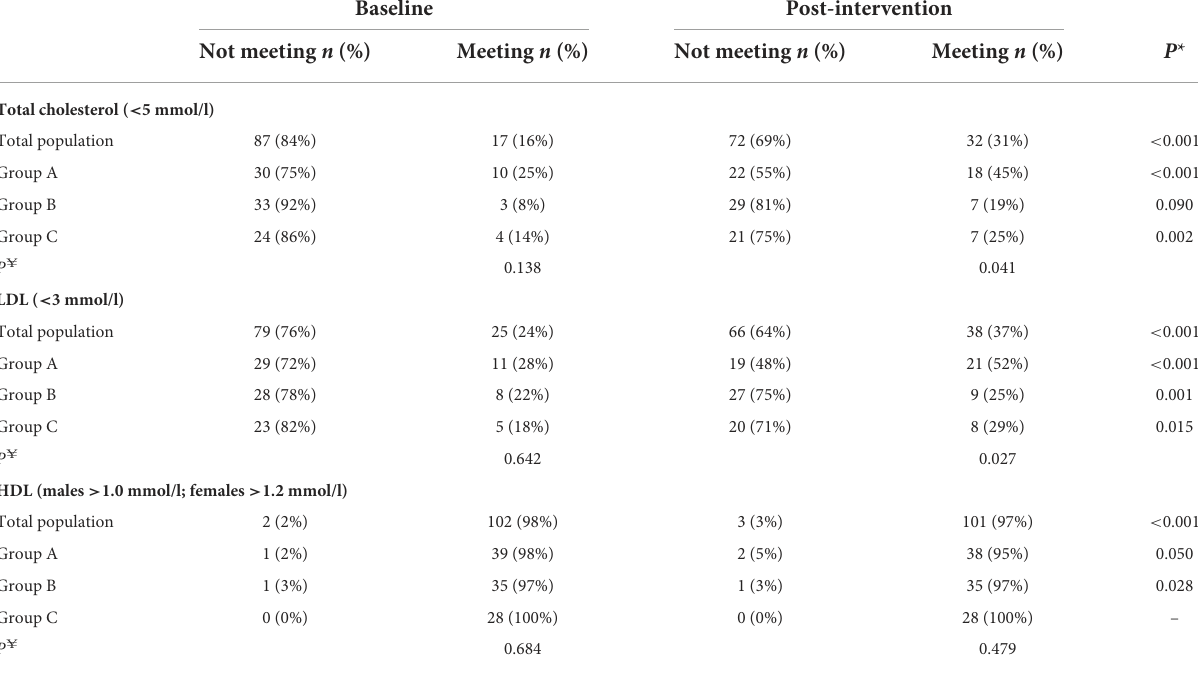
TABLE 5 Comparison of the population meeting the WHO (25) recommended clinical cut-offs between baseline and